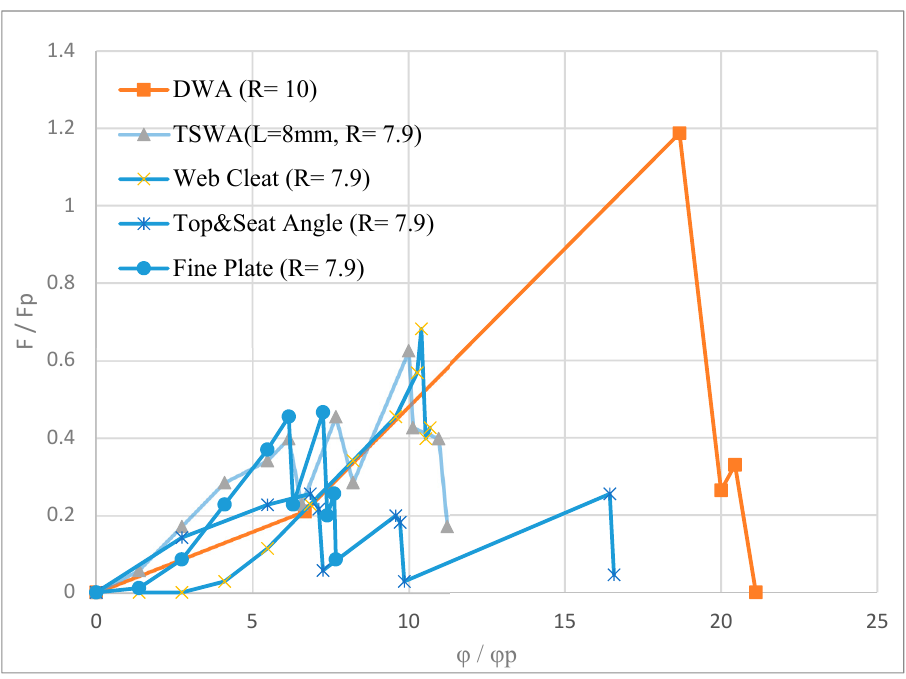
Figure 4. Normalized pushdown resistance against normalized rotation of flexible connections.